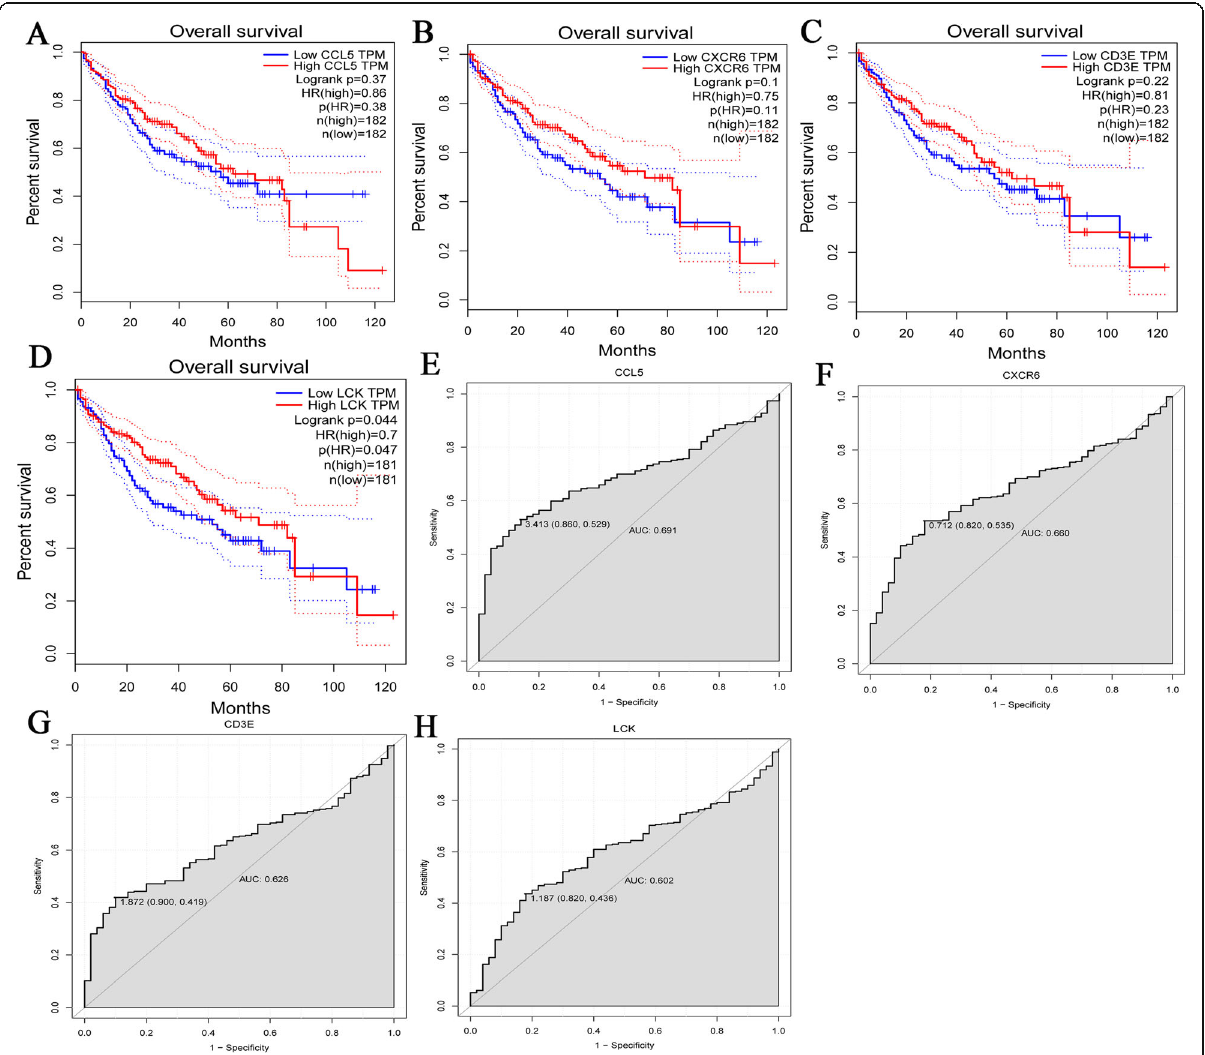
Fig. 10 Prognostics and diagnostic analysis of CCL5, CXCR6, CD3E and LCK. A Survival curve of CCL5; B Survival curve for CXCR6; C Survival curve for CD3E; D Survival curve for LCK. P < 0.05 was considered to indicate a statistically significant difference. E ROC curve for CCL5; F ROC curve for CXCR6; G ROC curve for CD3E; H ROC curve for LCK. ROC, receiver operating characteristic; AUC: area under